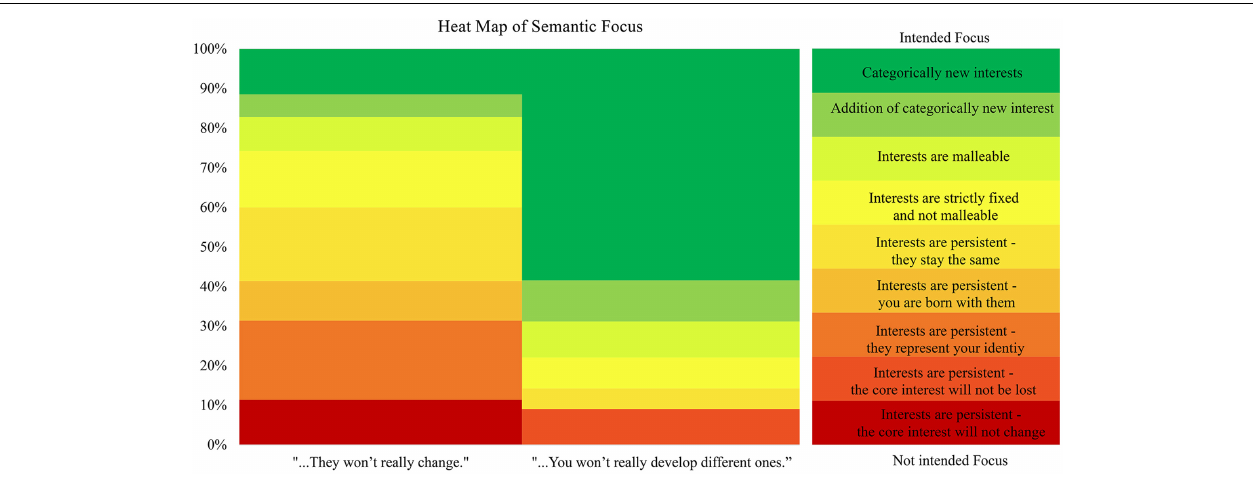
Frontiers in Education |